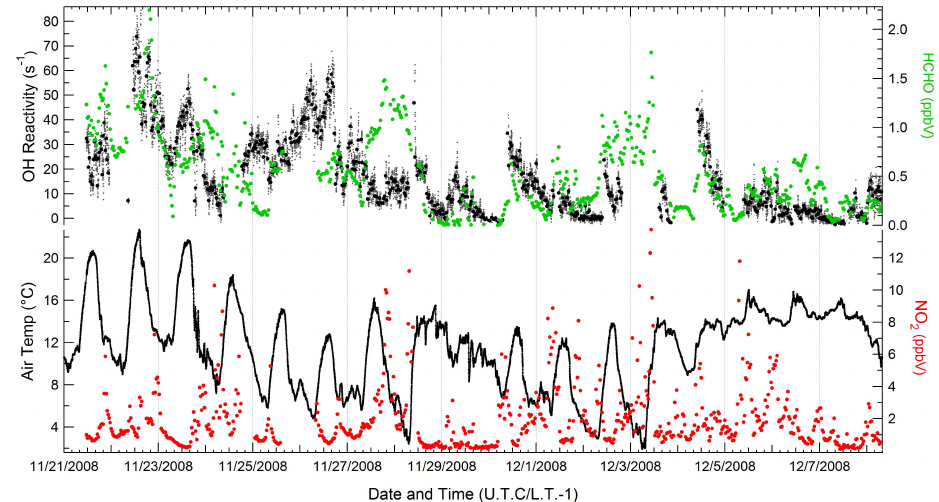
Fig. 2. Time series of the 1min (gray dots; n = 11584 measurements) and 30 minute averages (black circles) of the OH reactivity data during the DOMINO campaign (top panel) and the 30min averages of the formaldehyde (HCHO) mixing ratios (green circles), the ambient temperature (solid black line) and nitrogen dioxide (NO 2 ) mixing ratios (red circles) (bottom